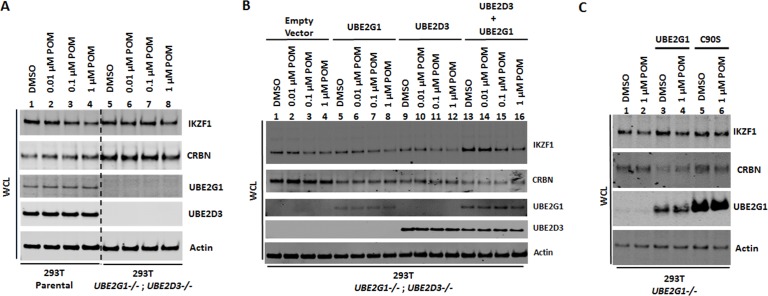
Input protein levels for the in vivo ubiquitination studies corresponding to Figure 5.(A) Total input for Figure 5A. Immunoblot analysis of 293T parental and UBE2G1-/-;UBE2D3-/- (Clone 4) cells transfected to produce 8xHis-Ubiquitin, cereblon and IKZF1-V5. (B) Total input for Figure 5B. Immunoblot analysis of 293T parental and UBE2G1-/-;UBE2D3-/- (Clone 4) cells transfected to produce 8xHis-Ubiquitin, CRBN, IKZF1-V5 with or without UBE2G1 and/or UBE2D3. (C) Total input for Figure 5C. Immunoblot analysis of 293T parental and UBE2G1-/- (Clone 13) cells transfected to produce 8xHis-Ubiquitin, CRBN, IKZF1-V5 with or without UBE2G1 wildtype or C90S mutant. In (A), (B) or (C), 48 hr after transfection, cells were treated with 10 µM MG-132 and POM at the indicated concentrations for additional 8 hr. All results shown in this figure are representative of three independent experiments.